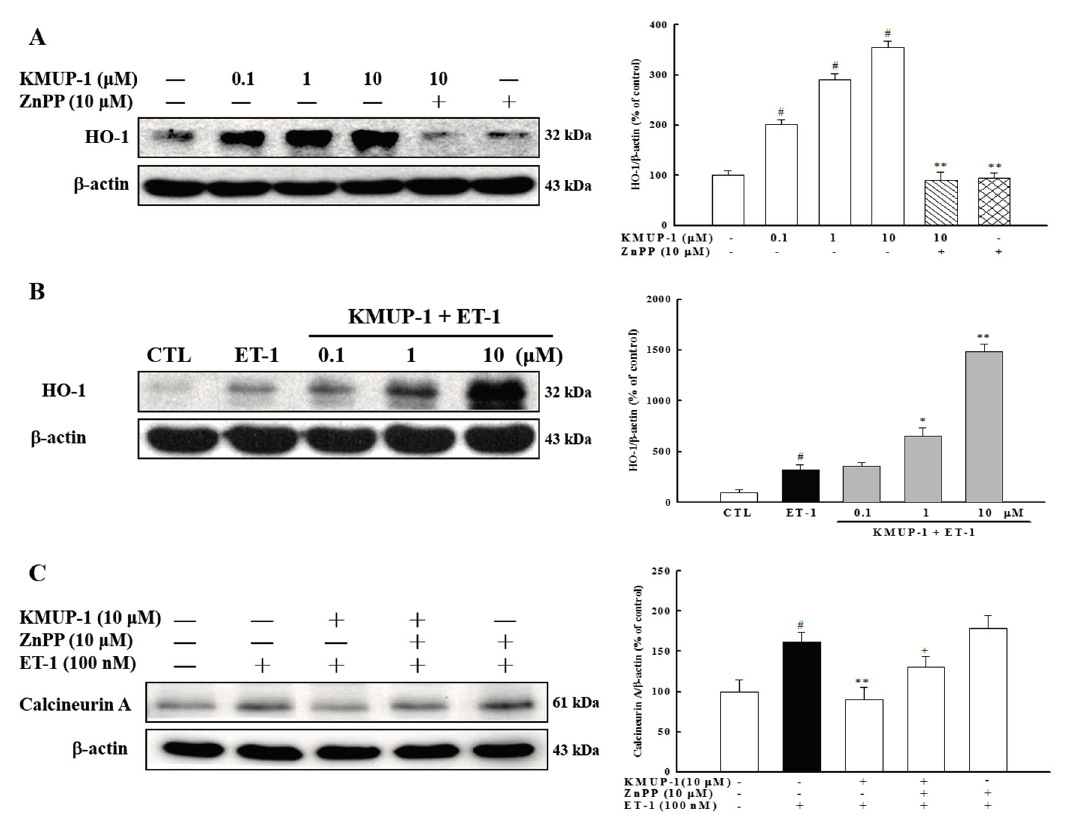
Figure 7. KMUP-1 treatment elevated the expression of HO-1 protein. ( A ) H9c2 cells were preincubated with ZnPP at 10 μ M for 1 h, followed by co-treatment with KMUP-1 or ( B ) combination with 100 nM of ET-1. Western blot analysis was conducted to measure the induction of HO-1 protein; ( C ) The expression of calcineurin A was analyzed. # p < 0.01 compared with control; * p < 0.05, ** p < 0.01 compared with ET-1 alone. + p < 0.05 compared with KMUP-1 10 μ M plus